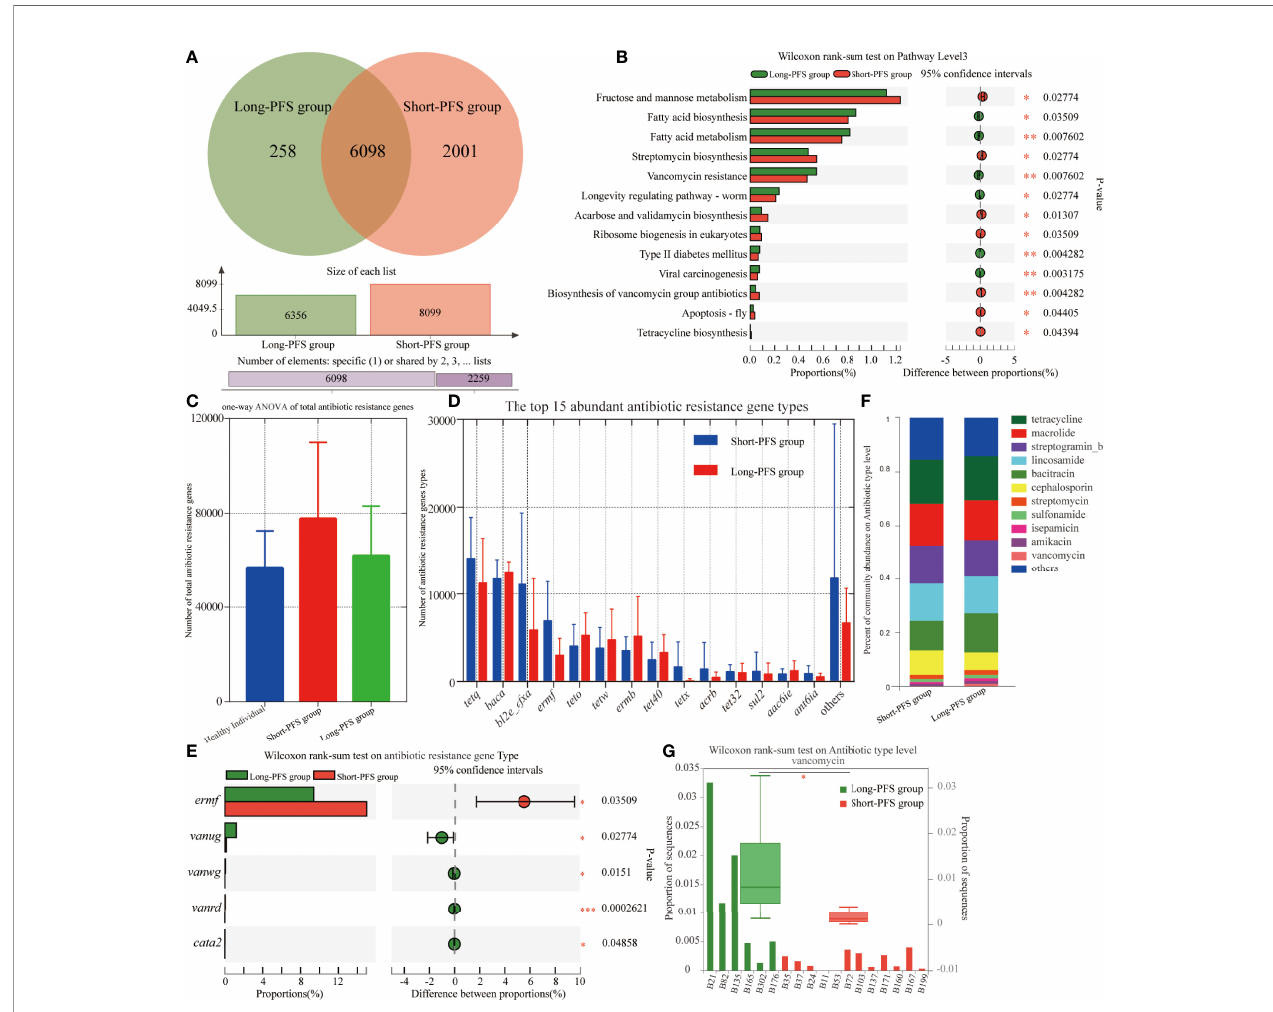
FIGURE 4 | Differences in functional pro fi le of gut microbiome between patients in long-PFS and short-PFS groups. (A) The venn diagram analysis between short- PFS group and long-PFS group in KEGG ORTHOLOGY (KO). (B) Signi fi cant difference was observed by Wilcoxon rank-sum test at KEGG level 3 between short- PFS and long-PFS groups. (C) The one-way ANOVA of total antibiotic resistance genes. (D) The histogram shows the top 15 abundant antibiotic resistance gene types in long-PFS and short-PFS groups. (E) Signi fi cant difference was observed by Wilcoxon rank-sum test at antibiotic resistance gene types. (F) Comparison of the top 11 most abundant antibiotic resistance genes between two groups. (G) The Wilcoxon rank-sum test analysis of vancomycin resistance gene types between two groups. *P < 0.05, **P < 0.01, and ***P <